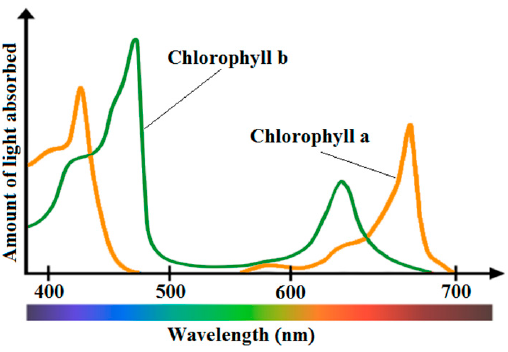
Figure 1. The Absorption Spectrum of both the chlorophyll- a and the Chlorophyll- b pigments. Narrow bands of imagery are required for the measurement of chl- a concentration and its spatial and temporal variations within a waterbody [92]. A review of the literature on the application of empirical approaches using multispectral sensors shows ambiguous results. While estimating chlorophyll using remote sensing techniques is possible and a lot of authors claim to achieve satisfying results using broadband sensors, several studies exist showed that the broad wavelength spectral data available on current satellites (i.e., Landsat, SPOT) do not permit discrimination of chlorophyll in waters with high suspended sediments [86]. This is especially due to the dominance of the spectral signal from the suspended sediments, more so in highly turbid and eutrophic waters [93,94]. Since the late 1970’s, many researchers developed bio-optical algorithms that initially were designed for oceans to determine water quality parameters. In these waterbodies, phytoplankton and its breakdown products are the sole determinants of optical properties of the water. In Case 1 waters, by employing an empirical model and interpreting the received radiance at different wavelengths, the concentrations of chl- a can be adequately estimated with satellite images [83]. In Case 1 waters, spectral bands in the blue to green region are appropriate to identify chl- a concentrations with acceptable precisions. However, in Case 2 waters due to the complexity of the constituents in water, the detection of chl- a is a sophisticated task and requires advanced approaches and techniques. In Case 2 waters (inland and coastal waters), the optical properties are determined, additionally to phytoplankton, by a composite of dissolved organic matter from a terrestrial origin, dead particulate organic matter and inorganic particulate matter. Therefore, determination of chl- a concentration is much more complex and less accurate as these constituents are not statistically correlated. Additionally, the simple fact that Gelbstoff absorption often masks the blue-green region in Case 2 waters implies chl- a algorithms developed for Case 1 waters are not applicable to Case 2 waters